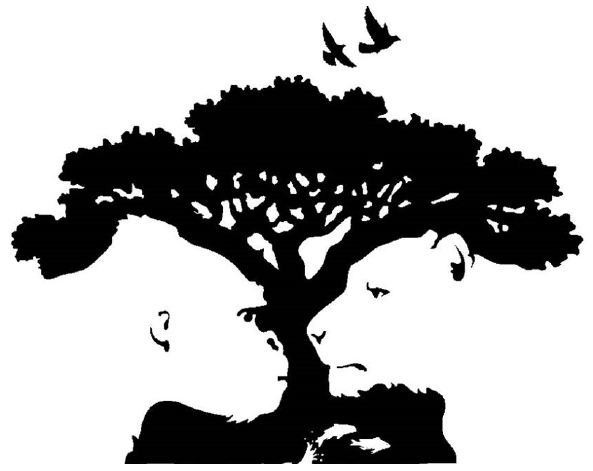
Figure 2. Gestalt Theory [21].